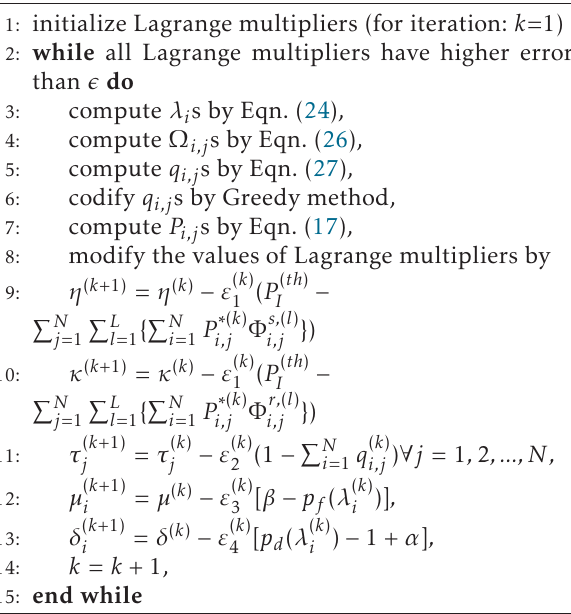
Algorithm 1 Proposed joint sensing, subcarrier pairing and power allocation.